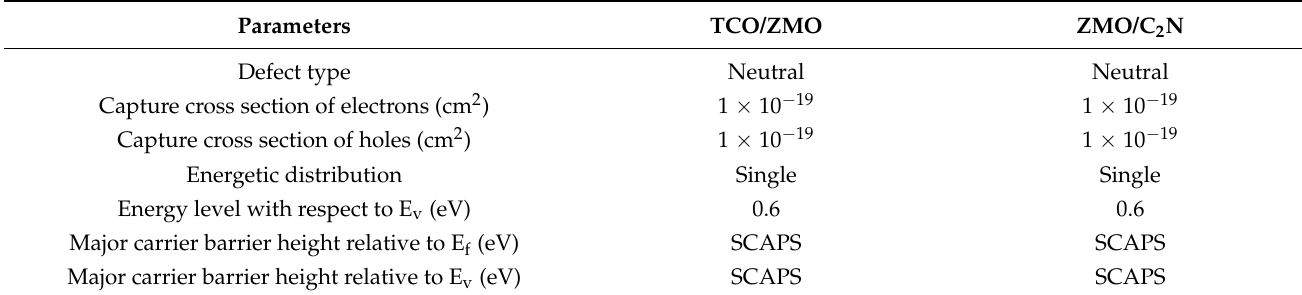
Table 2. Interface layer settings for the SCAPS simulation.